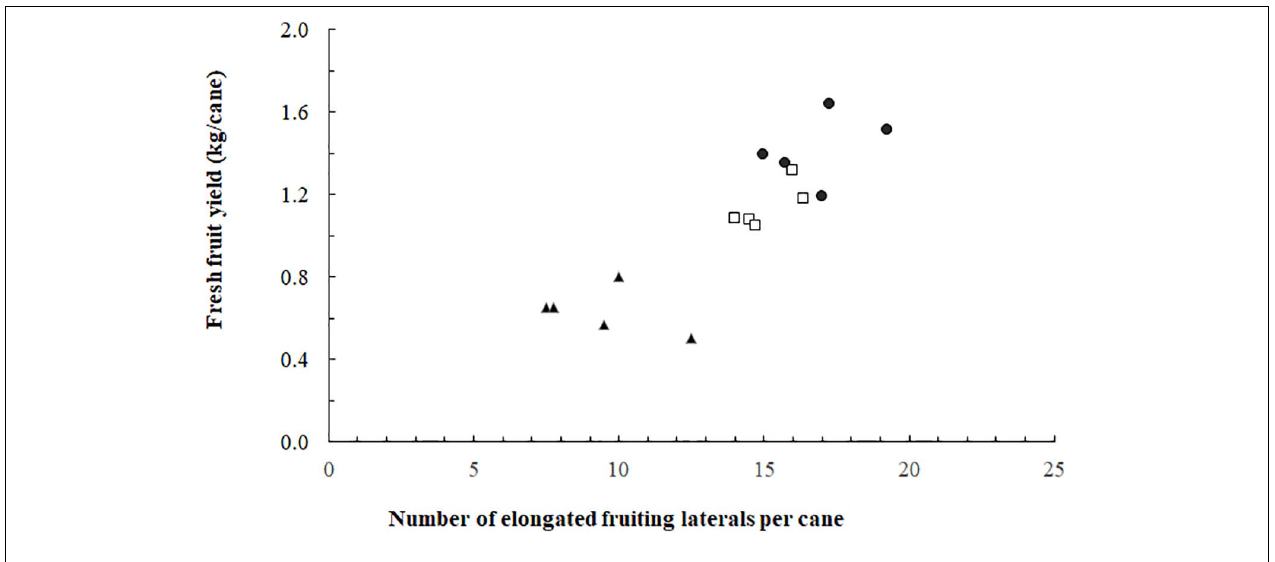
FIGURE 4 | Blackberry fresh fruit yield per cane as a function of the number of fruiting laterals per cane (spring crop cycle). Data for 0 ( (cid:78) ), 93 ( (cid:3) ), and 185 (